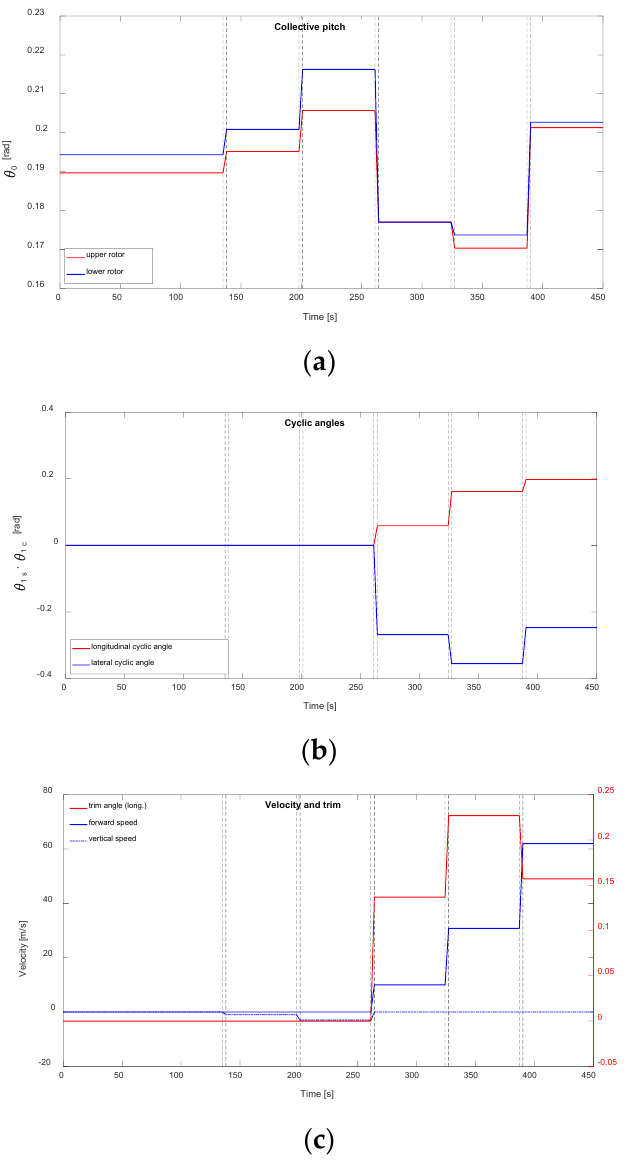
Figure 6. Sequence of input commands: ( a ) Collective pitch angle; ( b ) Cyclic pitch angles; ( c ) Euler pitch angle and velocity components in the body reference system.